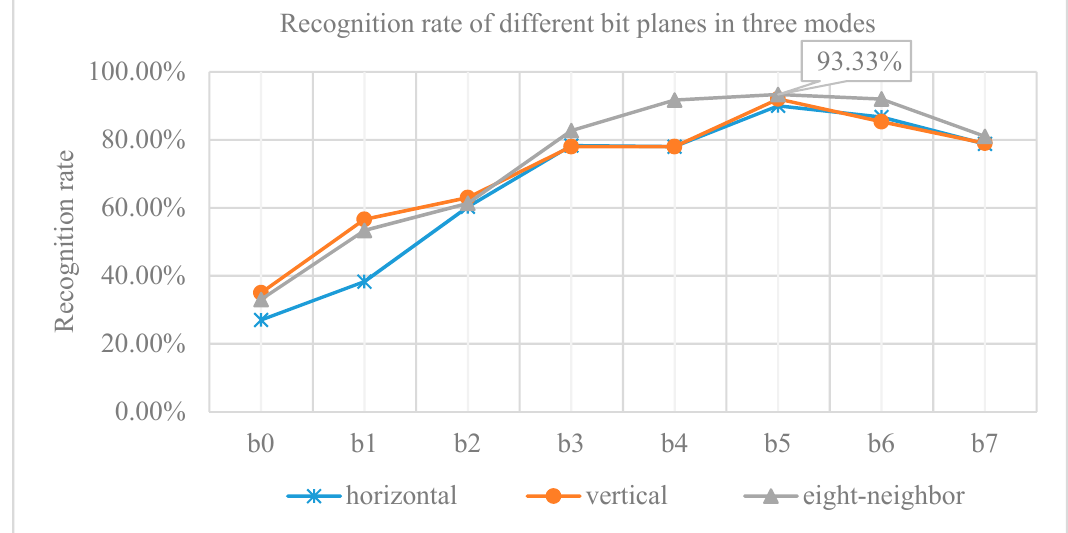
Figure 18. Recognition rate of different bit planes in three modes.